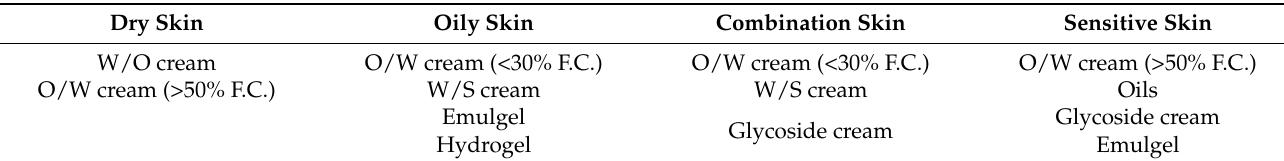
Table 4. Vehicle selection according to the facial-skin